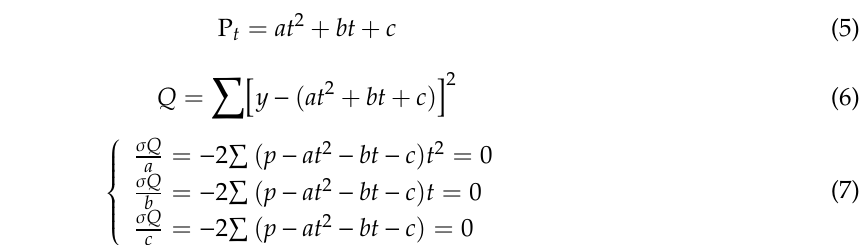
Figure 10. Wavelet filtering.